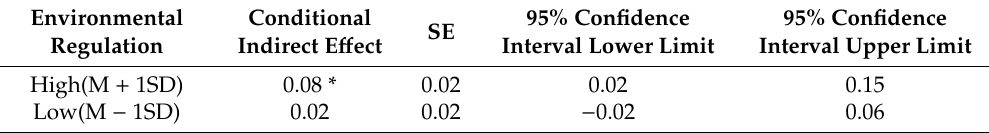
Figure 3. Interaction of green self-efficacy and environmental regulation on green product development performance. Table 4. Conditional indirect relationship between green transformational leadership and green product development performance through green self-efficacy at low and high values of environmental regulation.